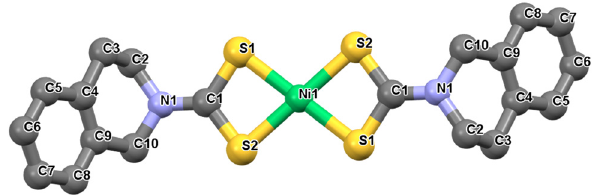
Figure 13: Molecular structure of [ Ni ( S 2 CN ( C 3 H 6 C 6 H 4 ) 2 ] . Redrawn from ref. [ 51 ] , with permission from Elsevier ( Copyright 2020 )